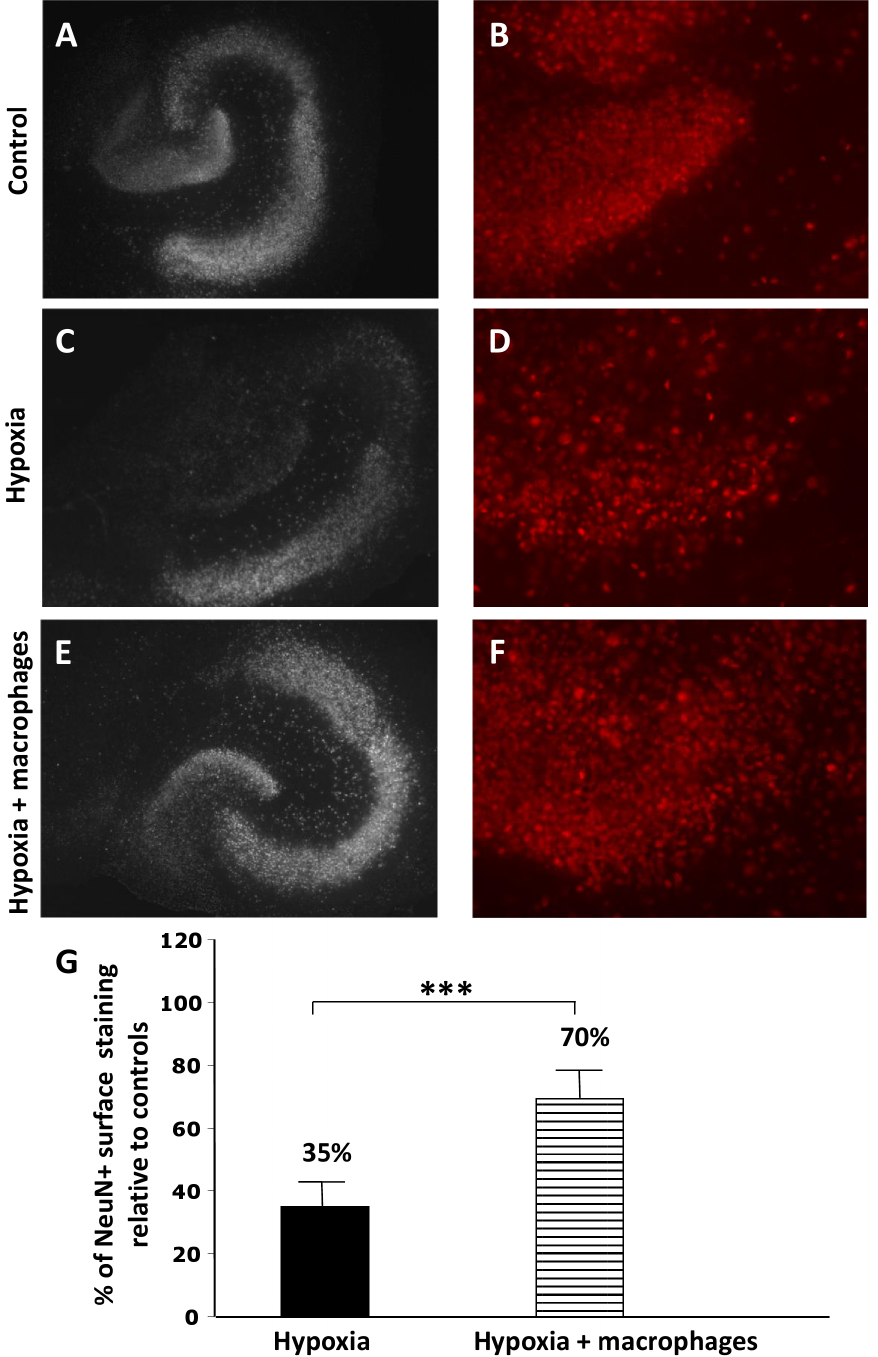
Figure 2. Co-cultured macrophages prevent hypoxia-induced neuronal cell death invitro. A – F: NeuN staining was performed on control organotypic hippocampal cultures (control OHCs), OHCs subjected to oxygen-glucose deprivation (OGD) (hypoxia) or OHCs subjected to OGD and co-cultured with macrophages (hypoxia + macrophages). Low magnification views of hippocampal slices are shown in A, C and E. High magnification views of the dentate gyrus are shown in B, D and F. As compared to control hippocampal slices (A, B), neuron cell loss was demonstrated in oxygen/ glucose-deprived OHCs (C, D) and was found to affect the dentate gyrus systematically. In contrast, oxygen/glucose-deprived OHCs that were co- cultured with macrophages appeared partially protected from OGD-induced neuron cell death. G: A quantitative analysis of neuron density was performed in the dentate gyrus by measuring the area covered by NeuN staining relative to the area analyzed. An arbitrary value of 100% was attributed to the measures obtained in control OHCs. Data showed a mean 35% 6 8% neuron density relative to controls in oxygen/glucose-deprived OHCs (hypoxia) and that co-culture with macrophages (hypoxia + macrophages) allowed neuron density to reach 70% 6 10% relative to controls (Mann-Whitney, n=3 experiments in each group, ***: p , 0.001).